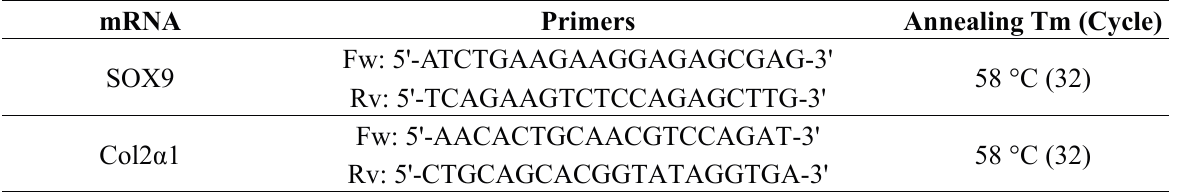
Table 1. Primer design for quantitative RT-PCR